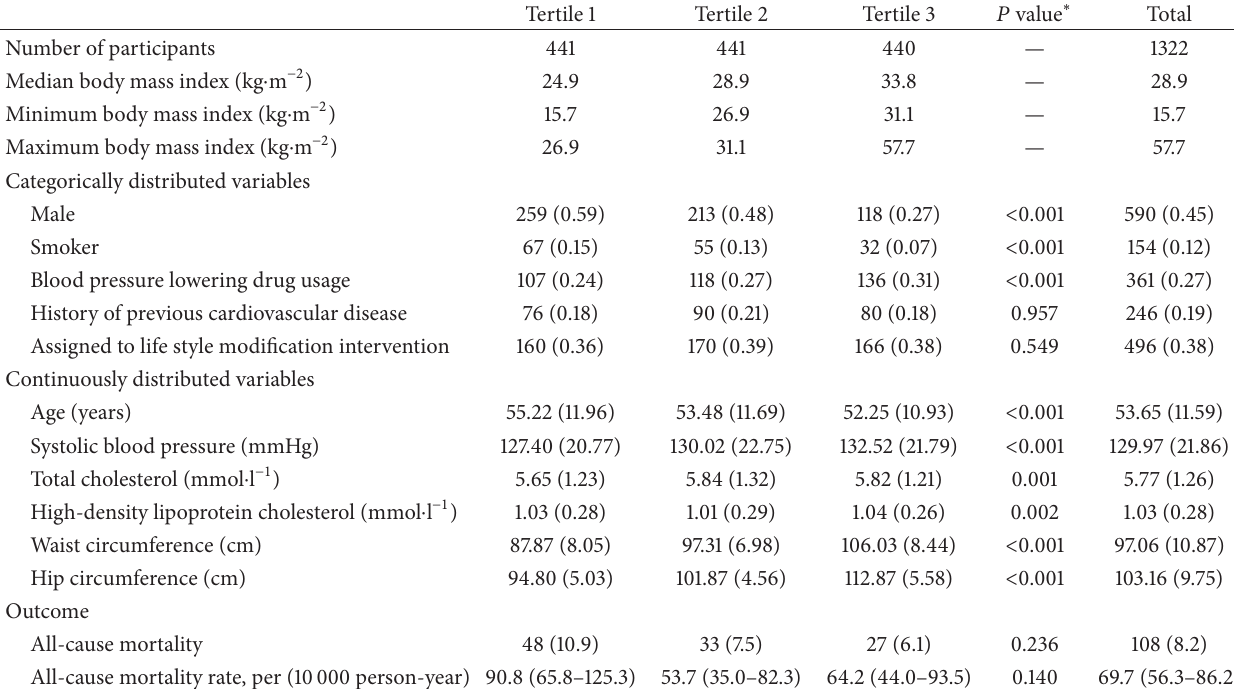
Table 1: Baseline characteristics of the participants with new-onset diabetes mellitus stratified by tertile of body mass index.